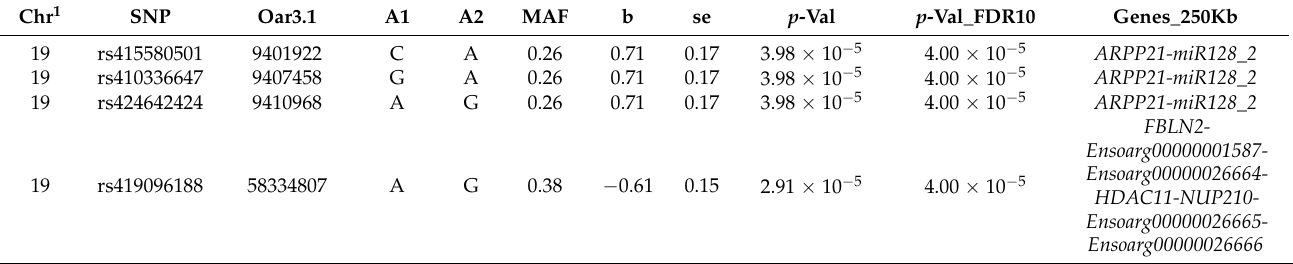
Table 2. MLMA results for significant SNPs at the chromosome level (FDR p < 0.10) for the estimated somatic cell score (SCS) trait. The SNPs are ordered according to their positions in the Oar 3.1 genome version (Ensembl release 81). Minor allele frequency (MAF) refers to allele 1